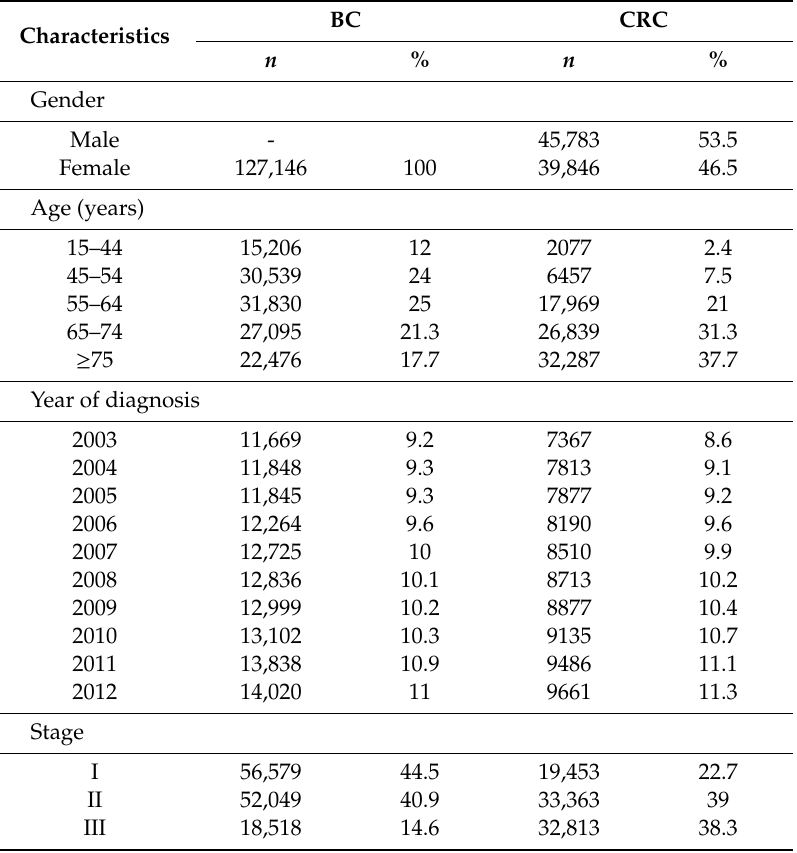
Table 1. Clinical characteristics of 127,146 breast cancer (BC) and 85,629 colorectal cancer (CRC) patients, diagnosed in